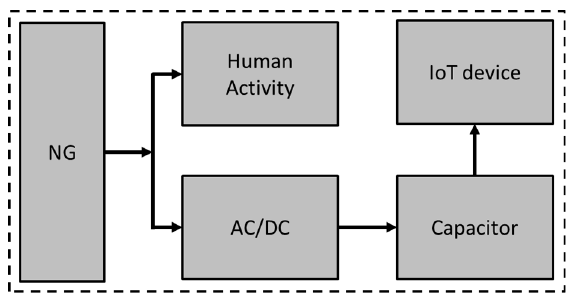
Figure 1. Block diagram of the people counting and motion sensor.